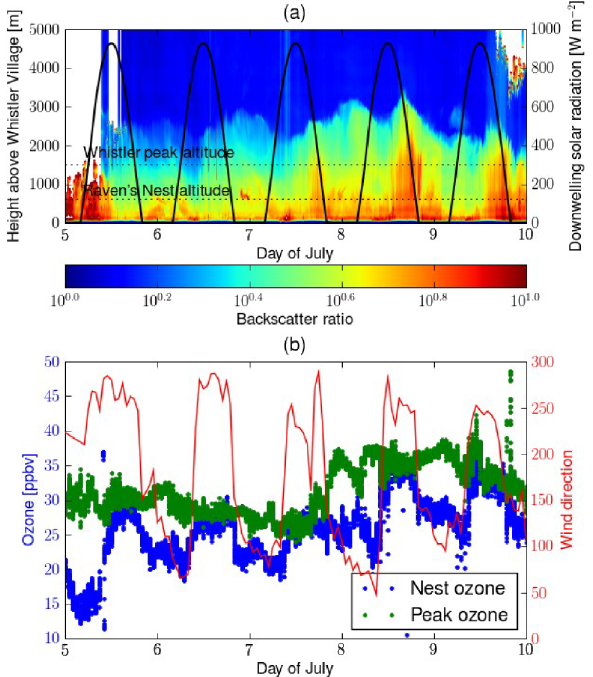
Fig. 5. Diurnal cycle averaged over 12:00PDT 6 July through 12:00PDT 7 July for (a) peak aerosol number from the SMPS, Raven’s Nest aerosol number from the SMPS and 1–2km Lidar backscatter ratio. (b) The same as (a) except with ozone mixing ratios rather than Lidar backscatter